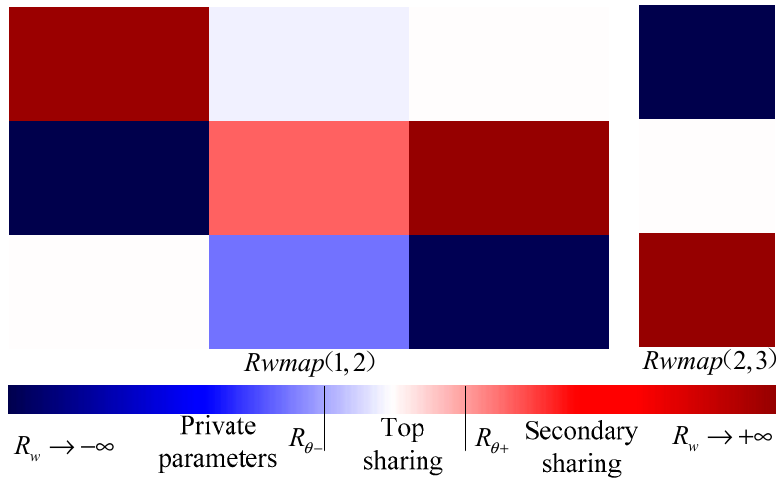
Figure 5. An example of Rw map.